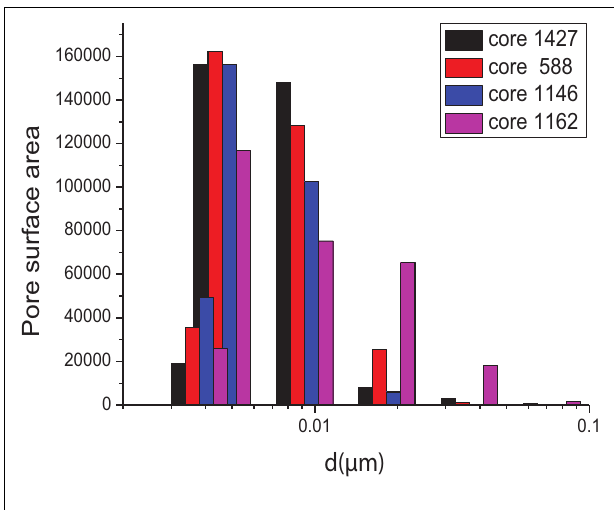
FIGURE 16 | Shale pressure hole distribution curve.